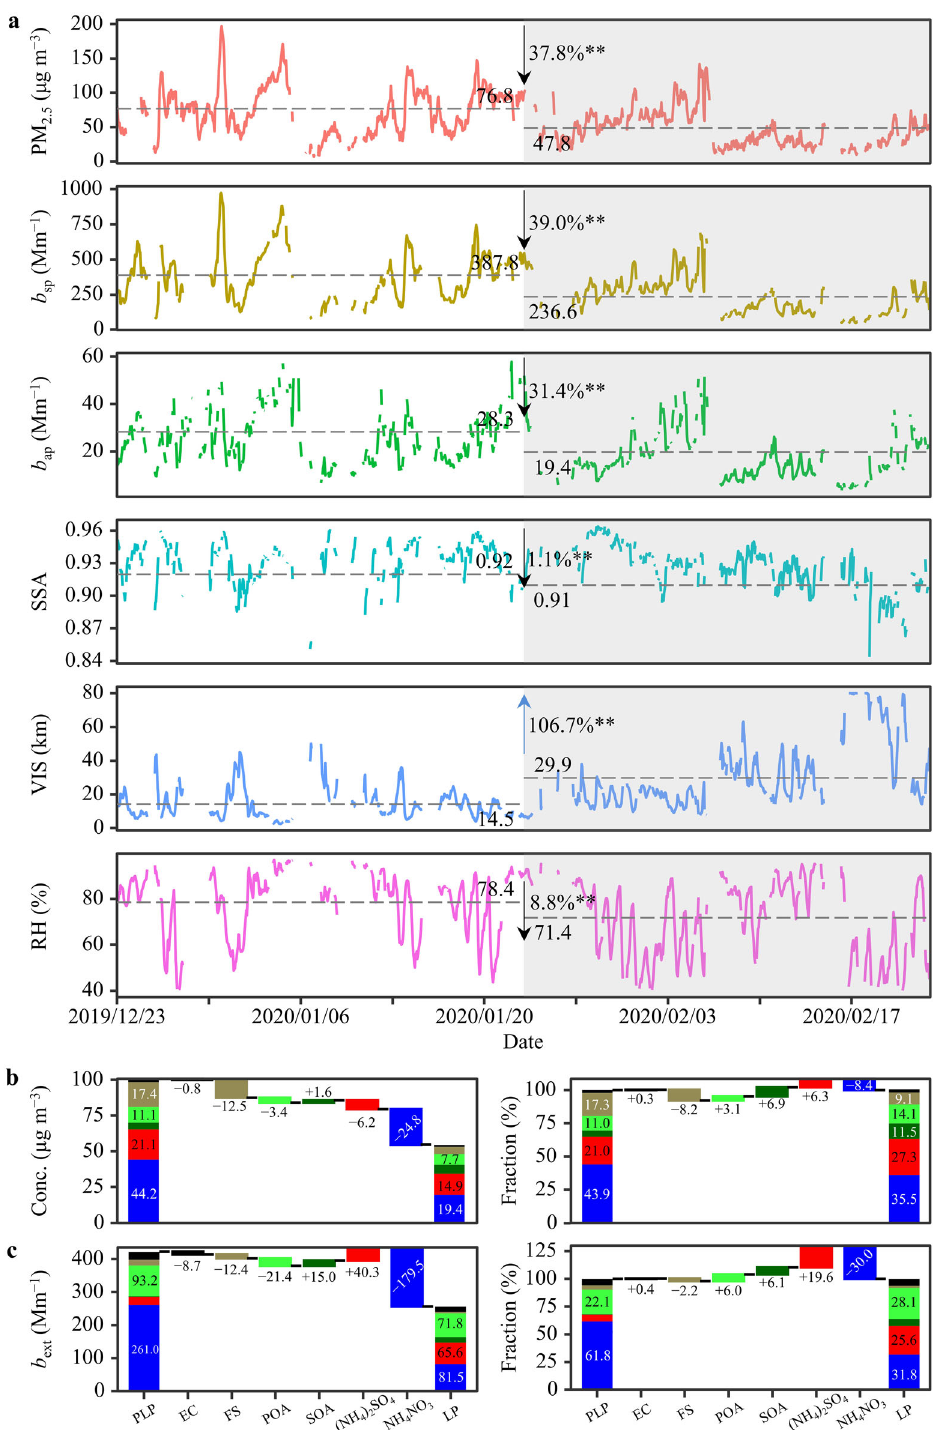
Fig. 1 Variations in PM 2.5 and ambient visibility between PLP and LP. a Time series of PM 2.5 , aerosol scattering coef fi cient ( b sp ), aerosol absorption coef fi cient ( b ap ), single scattering albedo (SSA), ambient visibility (VIS), and relative humidity (RH) for pre-lockdown period (PLP, 2019/12/23 – 2020/01/22) and lockdown period (LP, 2020/01/23 – 2020/02/22) in Wuhan. The dashed lines mean the average value; ** p < 0.01. b The differences in the mass concentrations and fractions of major chemical components in PM 2.5 for PLP and LP. c The differences in the contributions of major chemical components in PM 2.5 to aerosol extinction coef fi cient ( b ext ) for PLP and LP. EC elemental carbon, POA primary organic aerosol, SOA secondary organic aerosol, FS fi ne